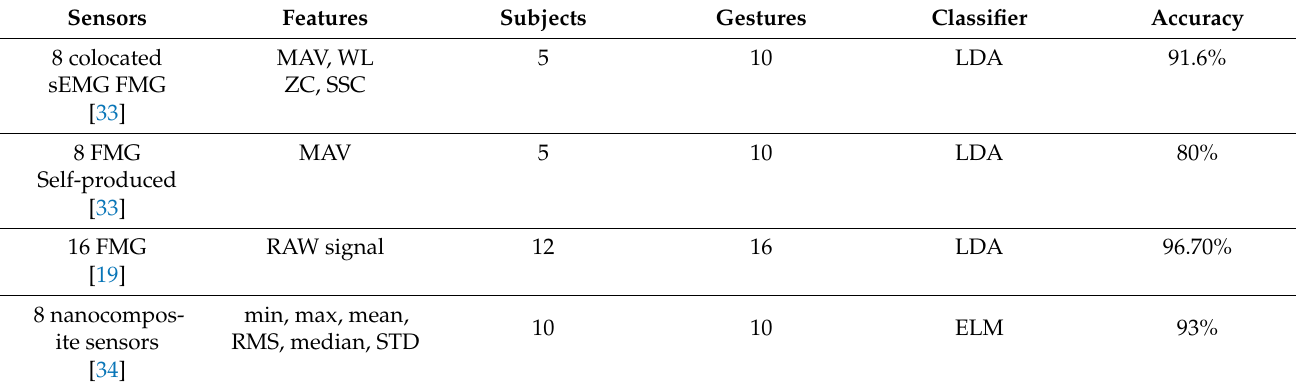
Table 2. State of the art for FMG-sensor-based ASL